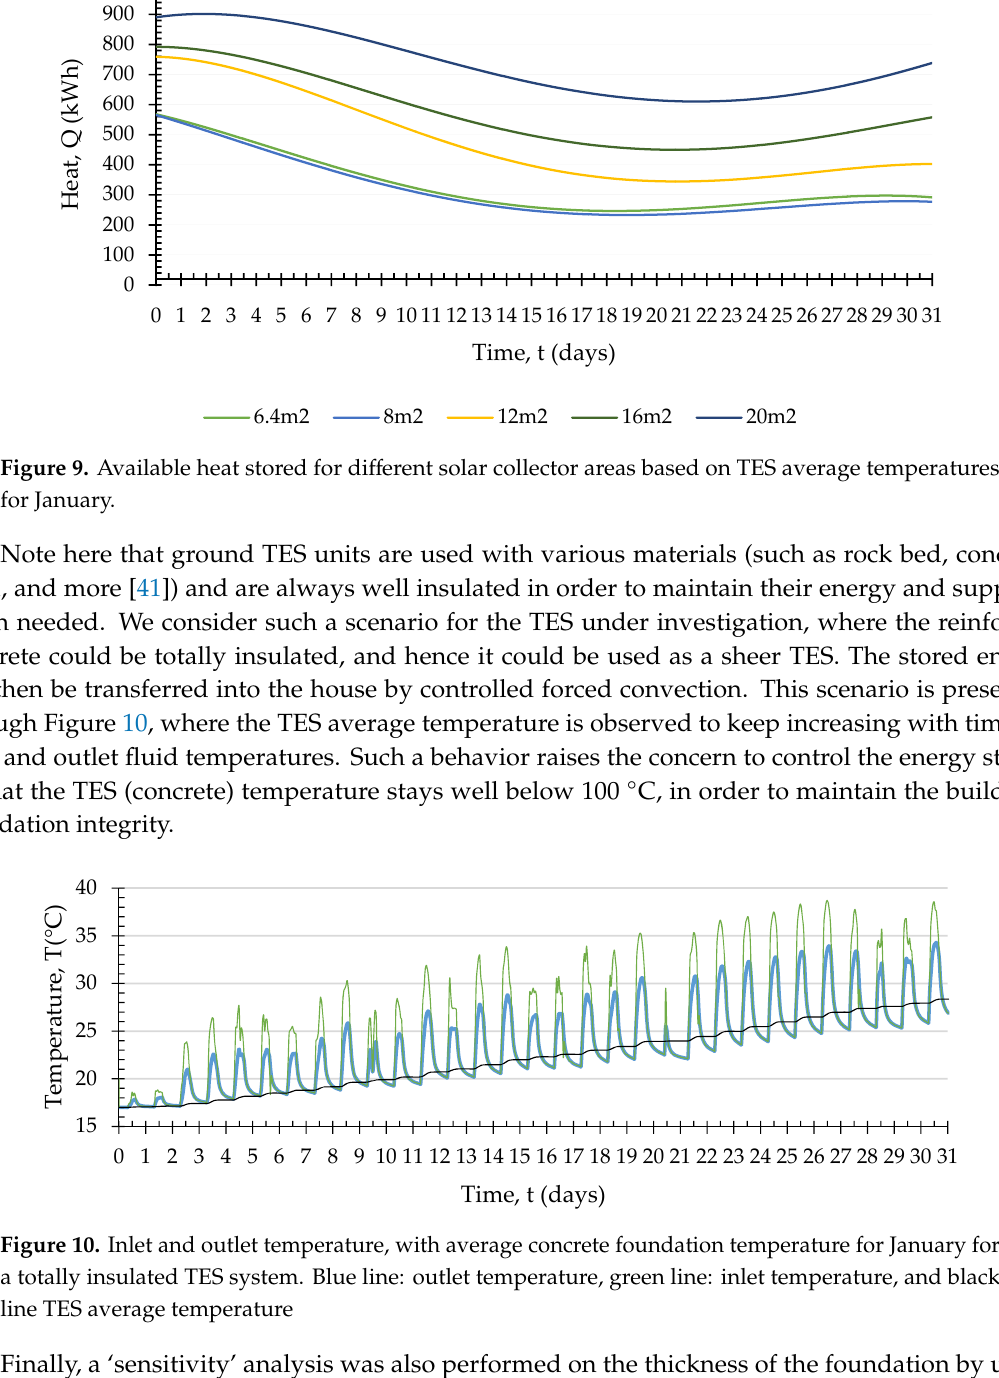
Figure 10. Inlet and outlet temperature, with average concrete foundation temperature for January for a totally insulated TES system. Blue line: outlet temperature, green line: inlet temperature, and black line TES average temperature